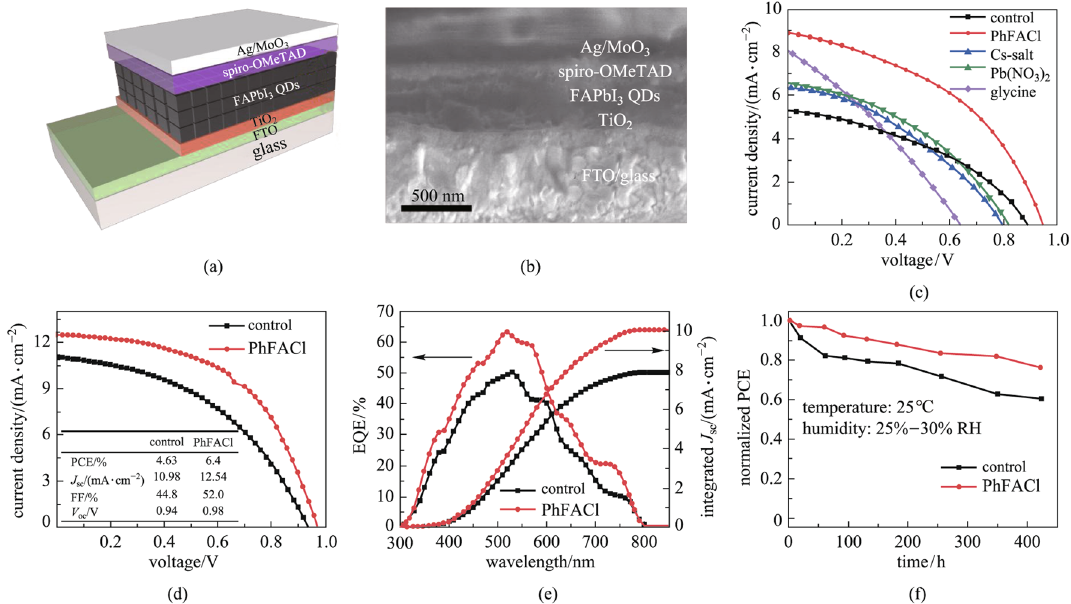
Fig. 4 Device architecture and photovoltaic performance of PQDSCs. a Device architecture and b cross-sectional SEM image of the PQDSC. c J–V curves of PQDSCs with different post-treatment processes. d J–V curves and inset summarized the photovoltaic parameters of PQDSCs, e EQE spectra and integrated J sc curves, and f stability of control and PhFACl-based